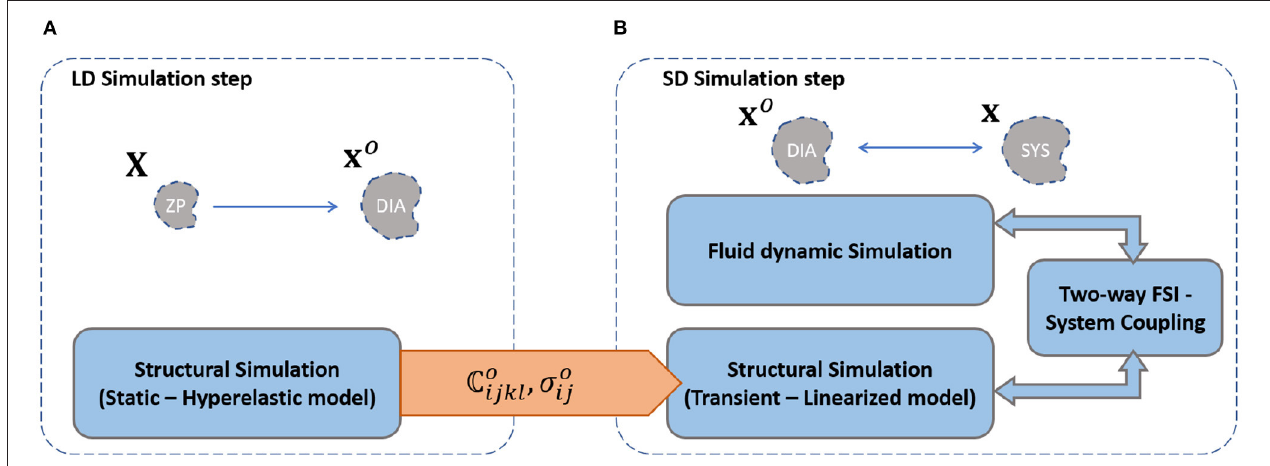
FIGURE 3 | Schematic of the workflow for the main simulation steps of SOL-linearized Simulation: (A) Large Deformation and (B) Small Deformation step.